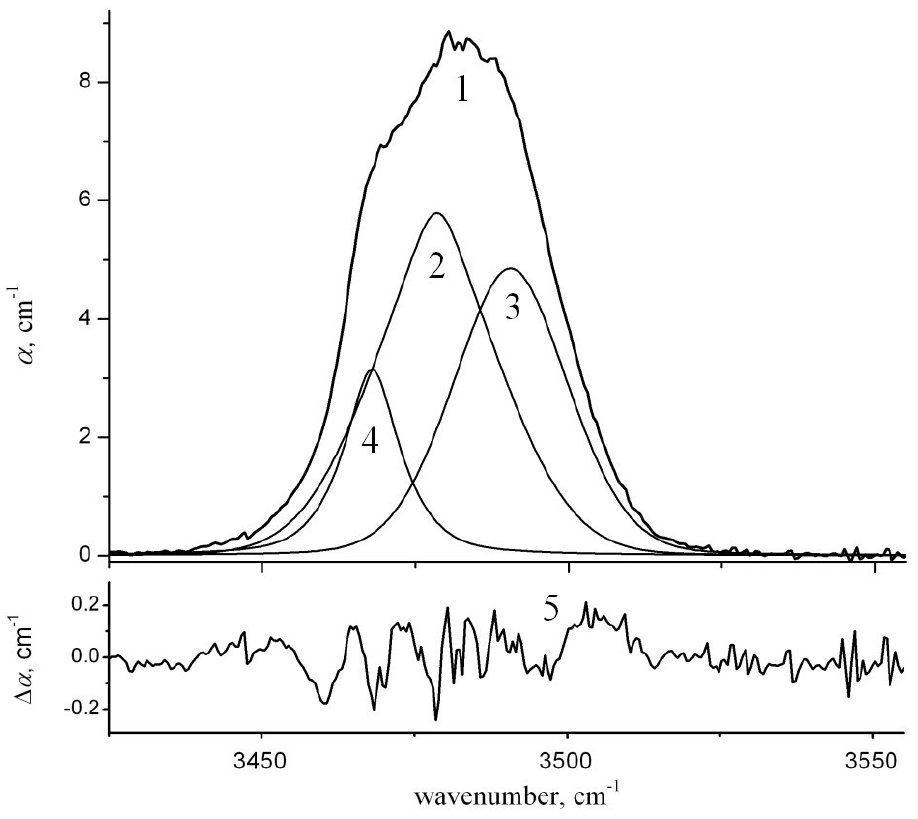
Figure 4. IR spectrum of CLN1: (1) integrated IR absorption spectrum of the CLN1 sample; (2)–(4) spectrum components; and (5) difference function ∆ α .